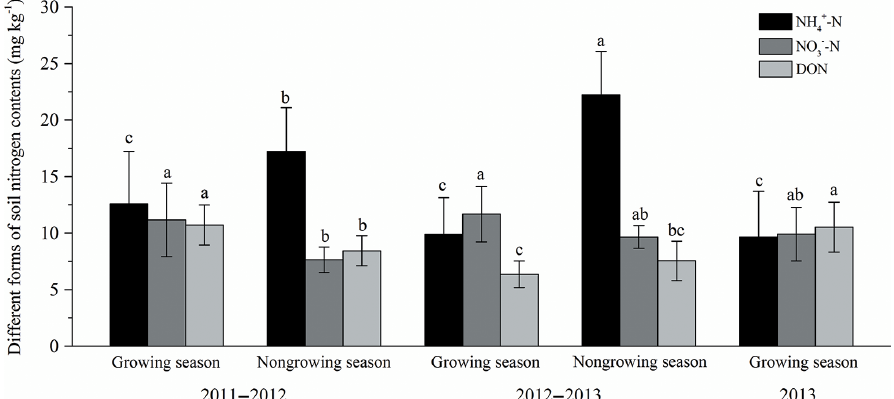
Figure 7. Dynamics of NH + n = 15).